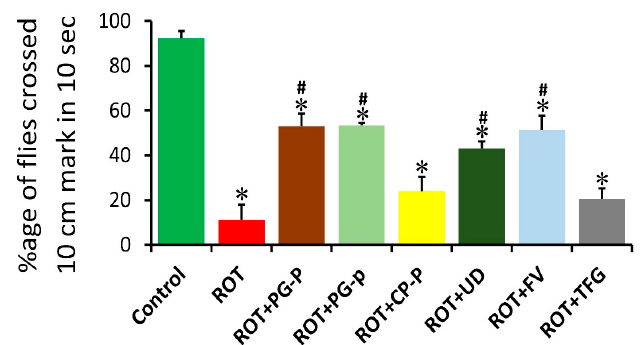
Figure 3. Wild-type D. melanogaster’s capability for climbing after 120 h. Rotenone, ROT; pomegran- ate peel, PG-P; pomegranate pulp, PG-p; papaya peel, CP-P; nettle leaves, UD; fennel, FV; fenu- greek, TFG. All observations are expressed as the mean ± SEM, n = 10, and were performed 3 times. Results were significant at p < 0.05. Significance was ascribed to * p <0.05 compared to the control; # p < 0.05 compared to